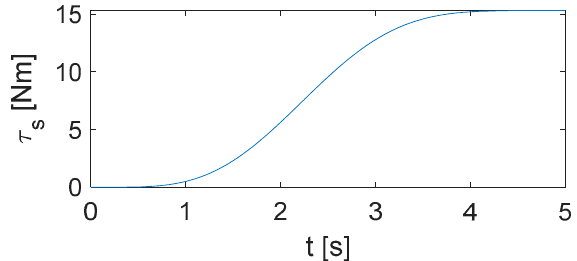
Figure 14. Elbow flexor torque (0.17 Nm/°) in function of θ 3 .